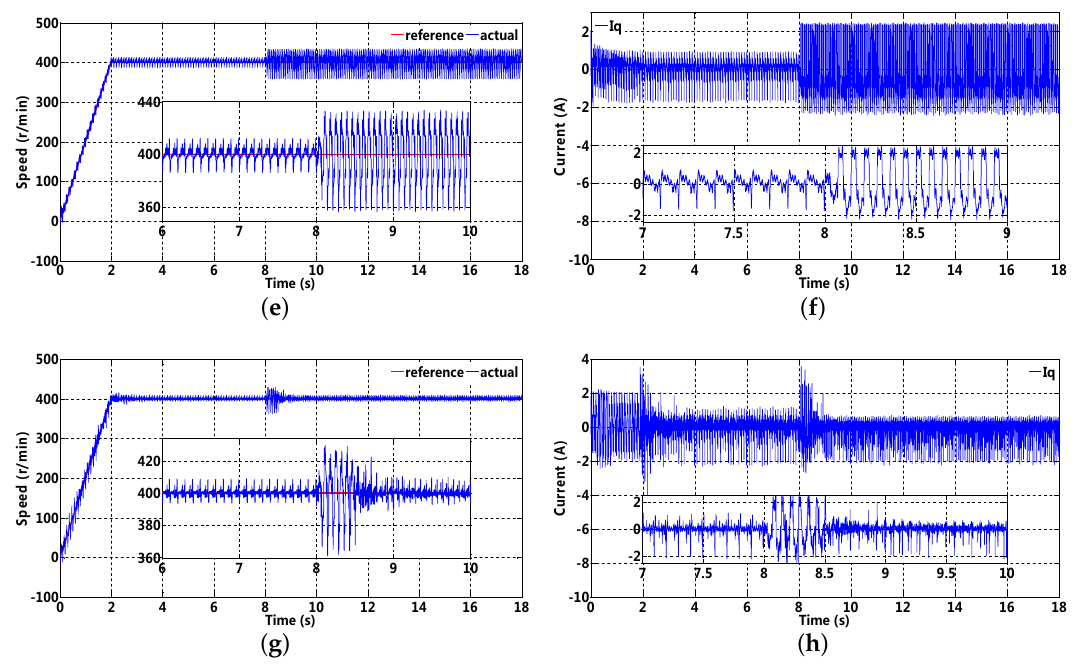
Figure 15. Speed and corresponding q -axis current based on the original PI controller (without disturbance compensation), DOB, PDOB and APDOB: ( a , b ) speed and corresponding q -axis current with the original PI controller; ( c , d ) speed and corresponding q -axis current with DOB; ( e , f ) speed and corresponding q -axis current with PDOB; ( g , h ) speed and corresponding q -axis current with APDOB.